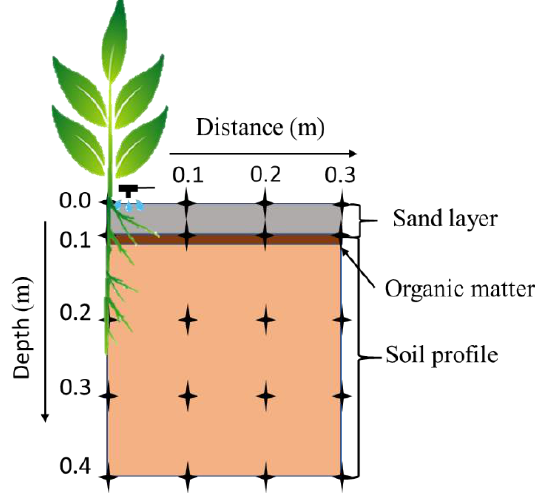
Figure 2. Layout of the sampling points in the experiment.